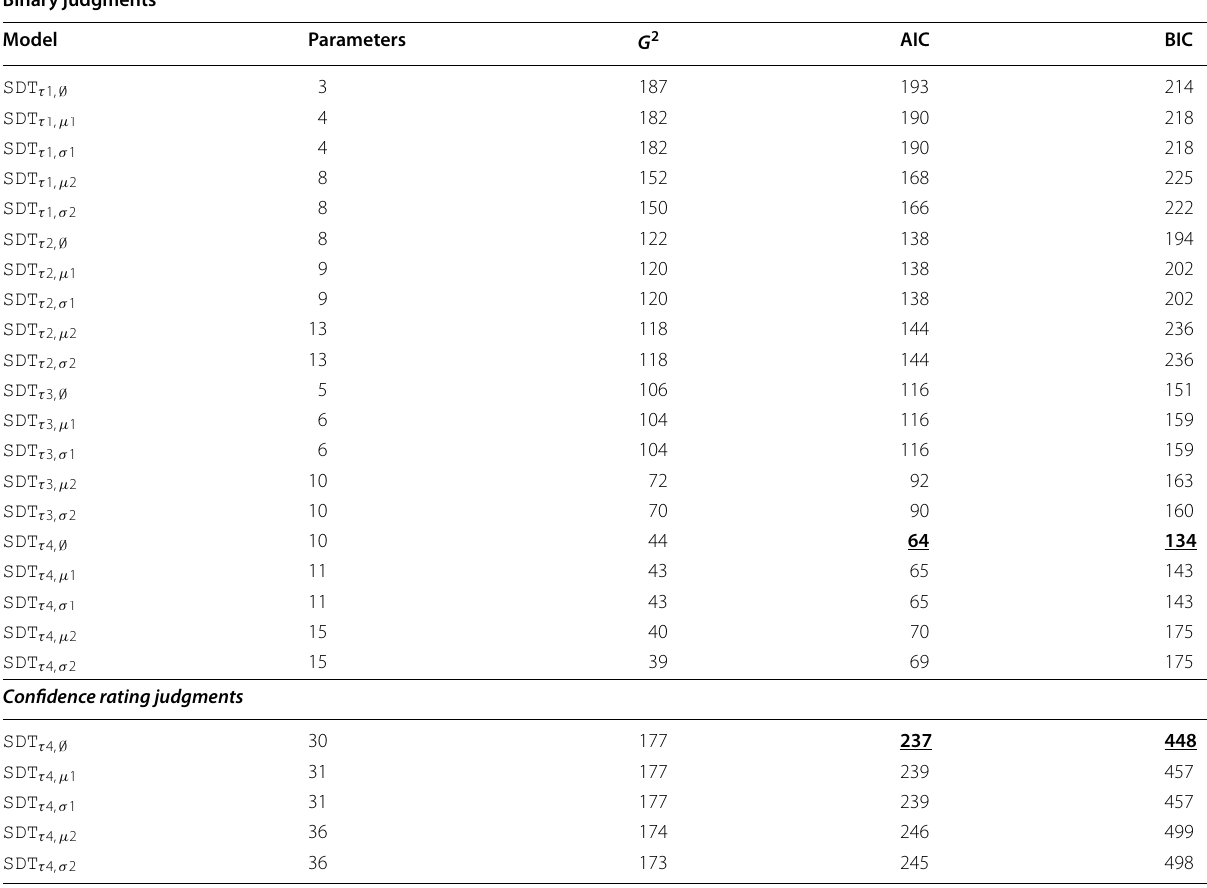
The best-performing values according to AIC and BIC are underlined and in bold font